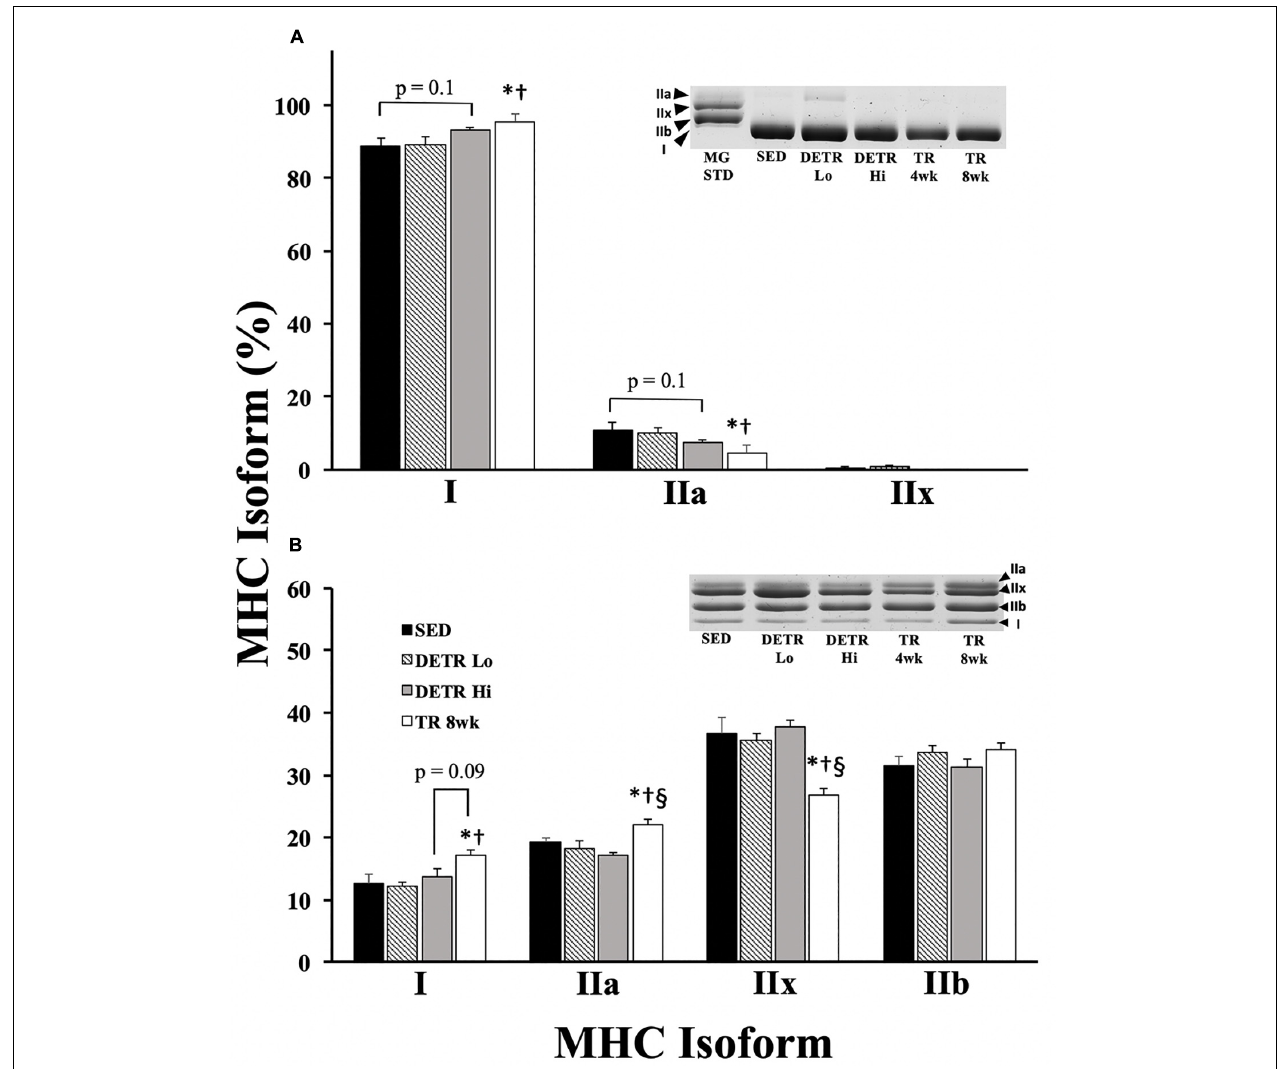
FIGURE 2 | Percent MHC isoform expression in SED, detrained (DETR), and trained (TR) soleus (A) and plantaris (B) muscles of adult female rats. DETR consisted of 4 weeks of voluntary running followed by 4 weeks of SED conditions and were categorized as high- (DETR Hi) or low- (DETR Lo) total running distances. Exercise-trained rats ran for 8 weeks (TR 8wk). The percentage of each isoform relative to the total MHC content was determined within each muscle; total MHC isolate from rat gastrocnemius muscle (MG STD) was used as a control to observe the migratory patterns of the samples. Representative gels show MHC isoform migration for soleus and plantaris muscles for all groups, including samples from TR 4wk rats (group results presented in Table 2 ). Values are means ± SEM. Significant differences from SED ( ∗ ), DETR Lo ( † ), and DETR Hi ( § ) are indicated; significance was set a p <